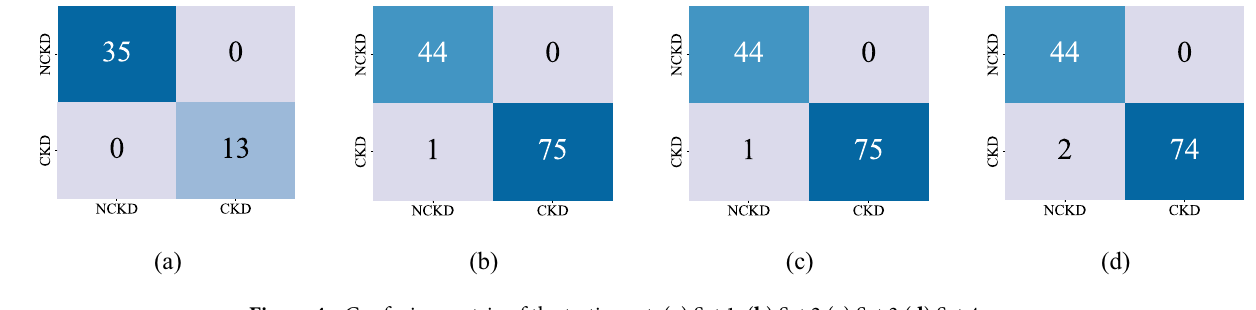
Figure 4. Confusion matrix of the testing set. ( a ) Set 1. ( b ) Set 2 ( c ) Set 3 ( d ) Set